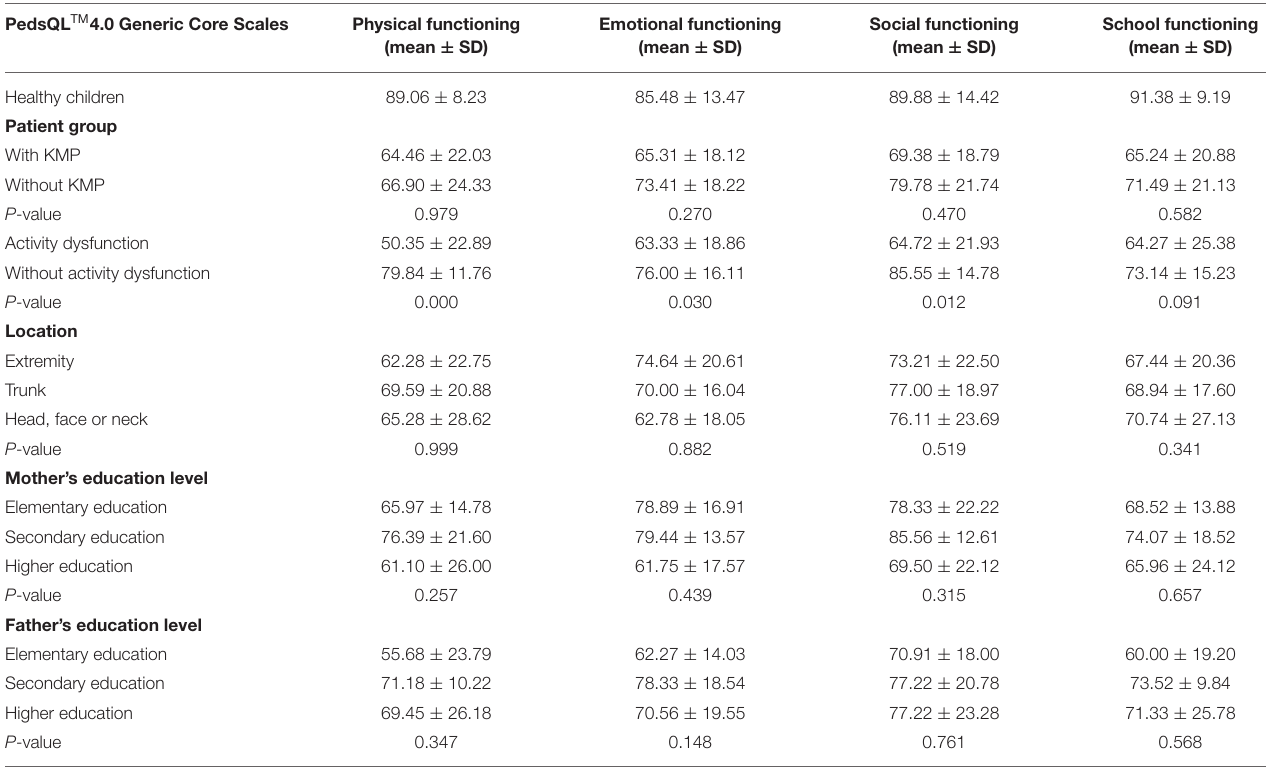
TABLE 7 | Analysis and score of each dimension of the PedsQL TM 4.0 Generic Core Scale (age > 24